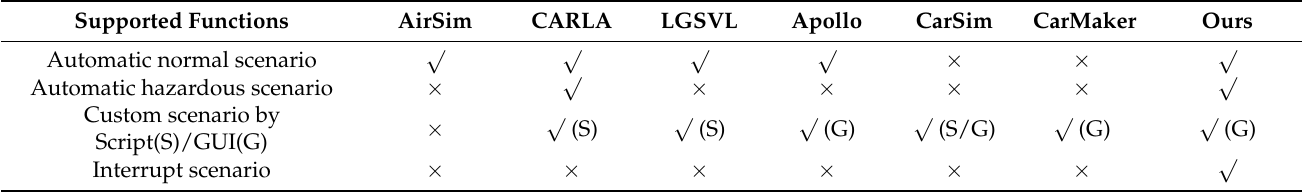
Table 4. The supported scenario functions in different